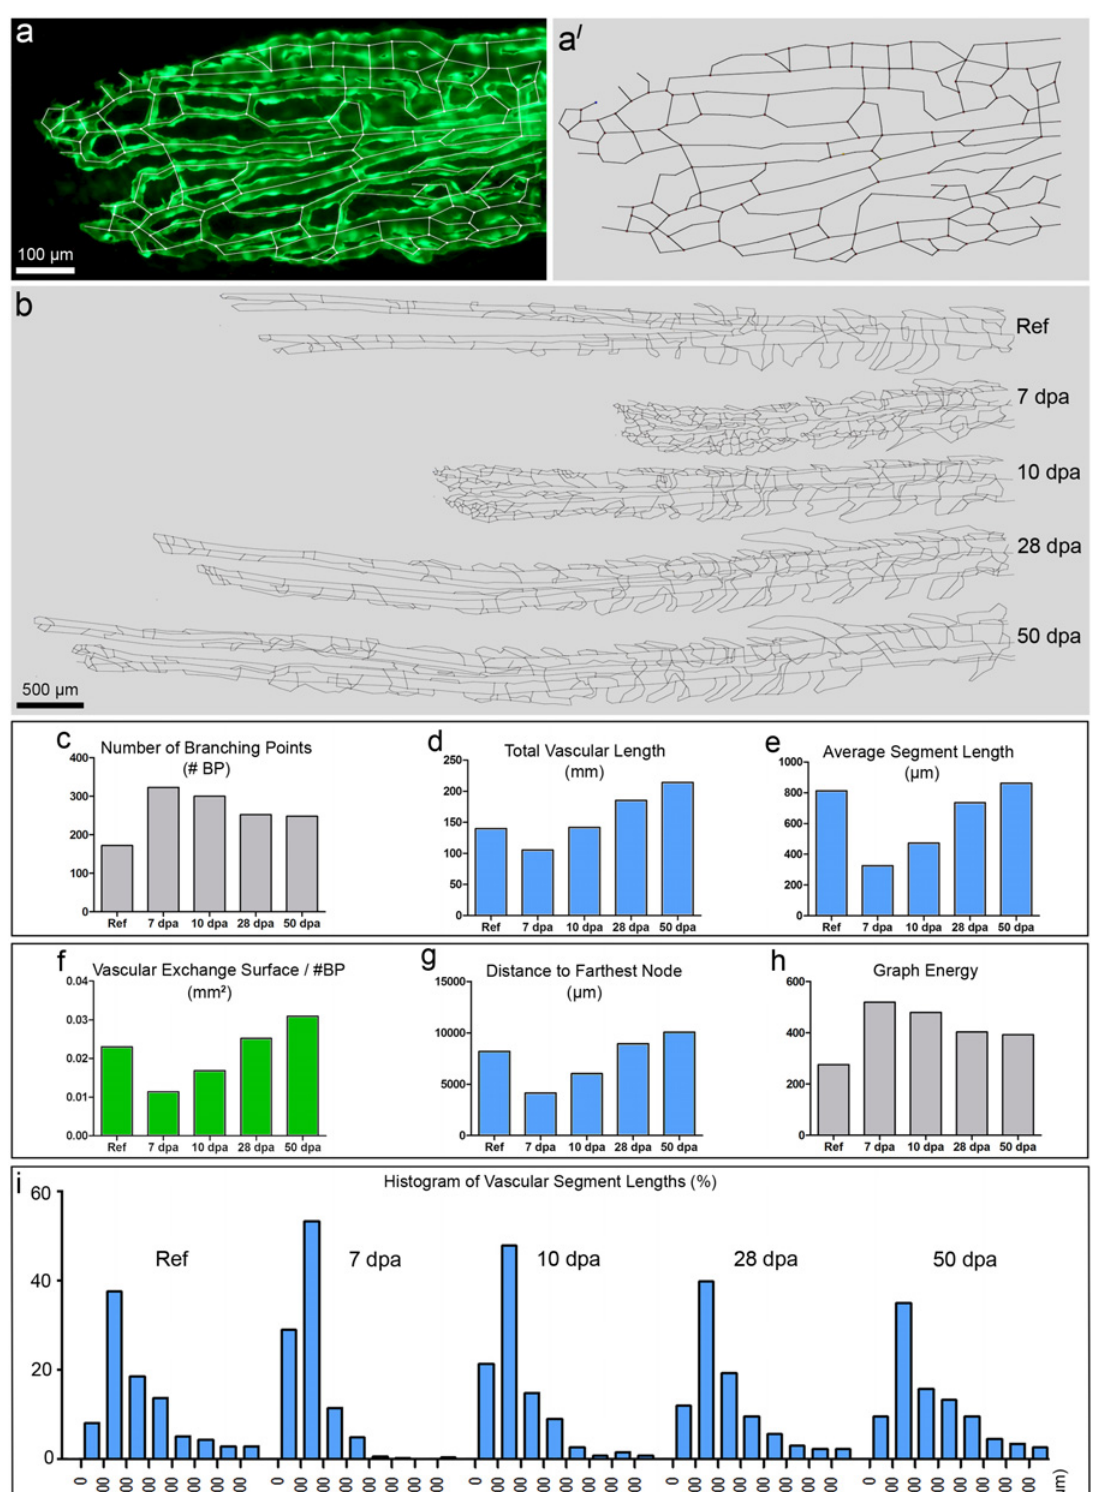
Fig 3. Skeletonization of the vasculature of the 4 th fin ray and its quantification. a displays the distal vasculature of the 4 th fin ray with overlaid skeleton. a ’ displays the same skeleton without the original image. b represents the skeletons of regenerated parts of the same 4 th ray at different time points (reference, 7, 10, 28 and 50 dpa). The graphs in c-i display dynamics of the parameters used for quantitative analysis of the skeletons at different time points: